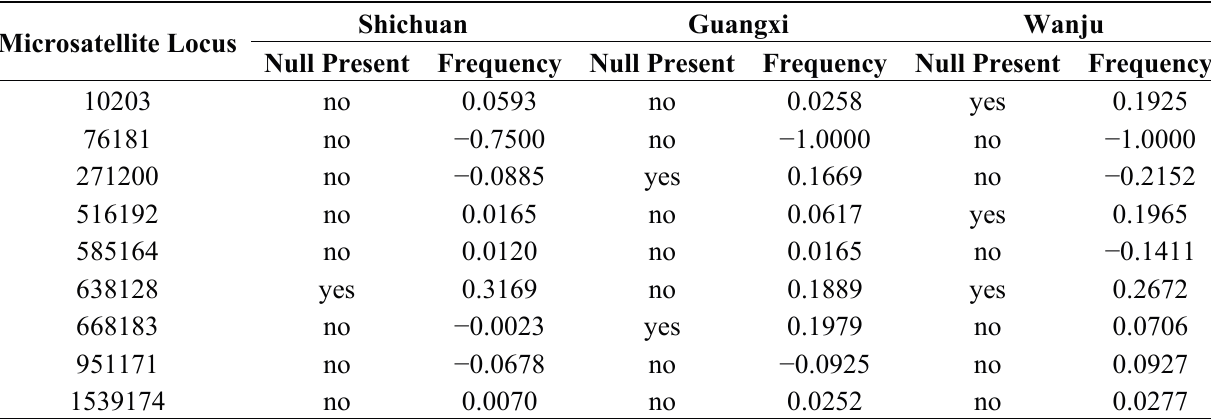
Table 2. The frequency of null alleles on each regional